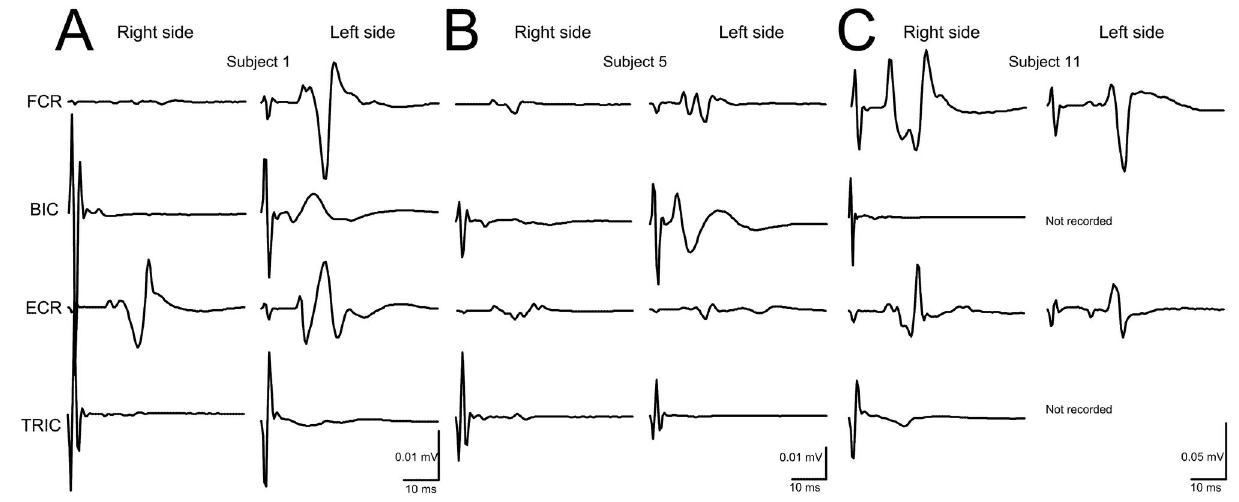
Figure 2. Waveforms of transpinal evoked potentials (TEPs). Representative examples of non-rectified waveform averages ( n = 10, elicited at 0.2 Hz) of TEPs recorded following transcutaneous electric stimulation of the cervicothoracic region from the flexor carpi radialis (FCR), biceps brachii (BIC), extensor carpi radialis (ECR), and triceps brachii (TRIC) muscles in both arms. doi: